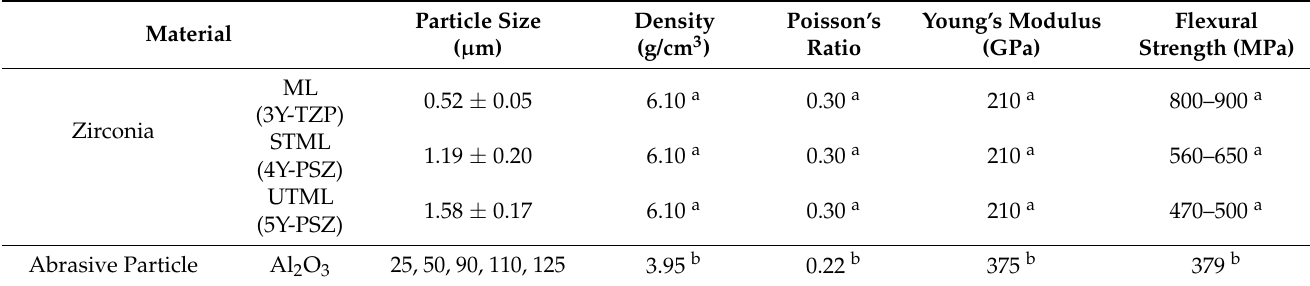
Table 1. Material elastic properties of 3D-FEA models.